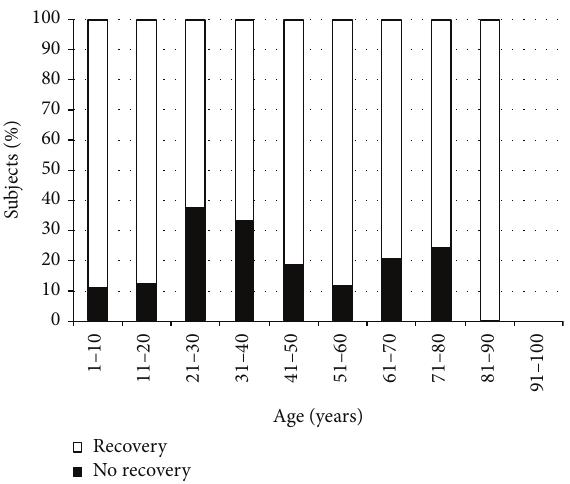
Figure 4: Percentage of OSD recovery rates by age group.